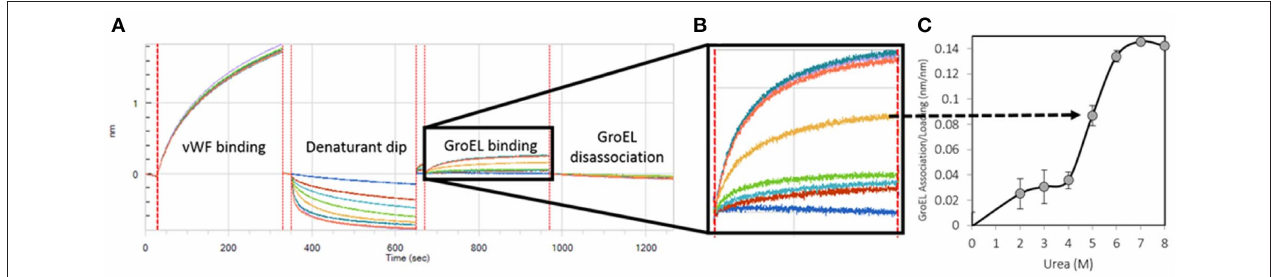
FIGURE 1 | Generation of a Kinetically Controlled Denaturant Pulse Isotherm for the Wild-type von Willebrand Factor A1-A2-A3 Triple Domain Fragment. (A) Protein is partially denatured during automated urea pulse steps, and (B) the GroEL binding amplitude was (C) plotted as a function of urea concentration to generate a kinetically controlled denaturation isotherm (Lea et al., 2016).